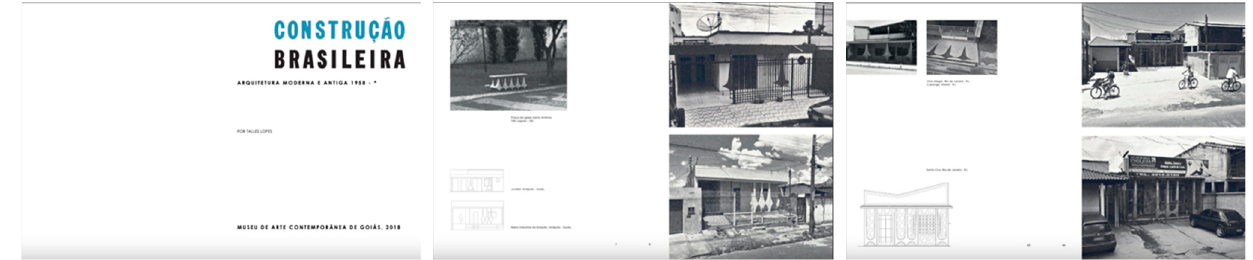
Figure 5. Talles Lopes, Brazilian Construction: Architecture Modern and Old, 1958- , 2018, photobook, courtesy of the artist.